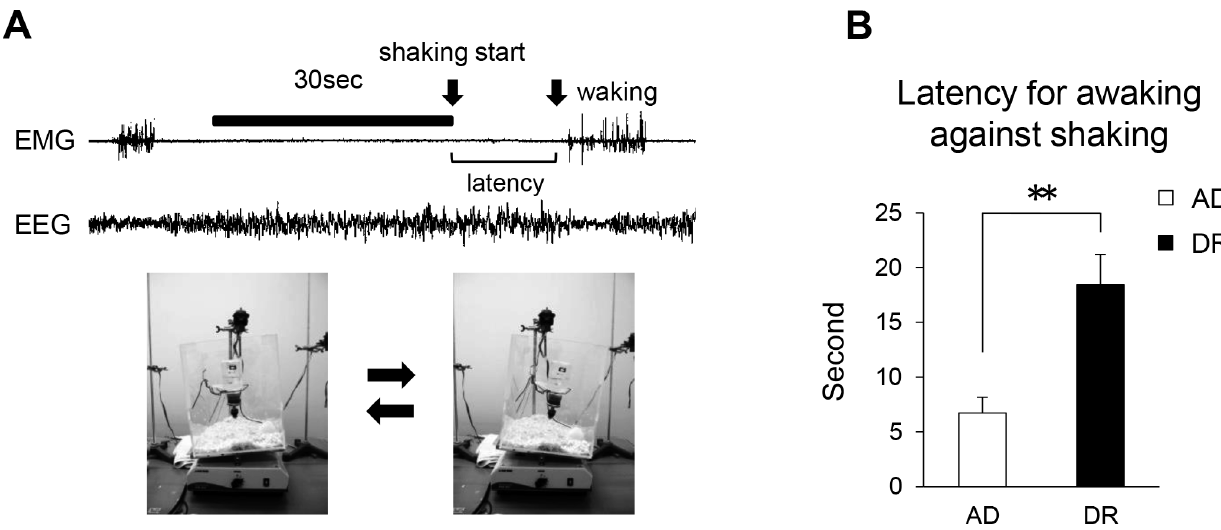
Figure 4. Threshold for waking by external stimuli (cage shaking) in adult offspring mice. Photos of the experimental setting for estimating waking threshold in mice against external sensory stimuli (A). Cage shaking was started 30 seconds after the continuous appearance of EEG delta waves as shown in upper traces. We measured the latency from the start of shaking to EEG arousal. The latency for waking following shaking stimuli (B). Open bars indicate AD mice. Closed bars indicate DR mice. Data represent means 6 SEM (B; n=6). **p , 0.01 indicates a significant difference.